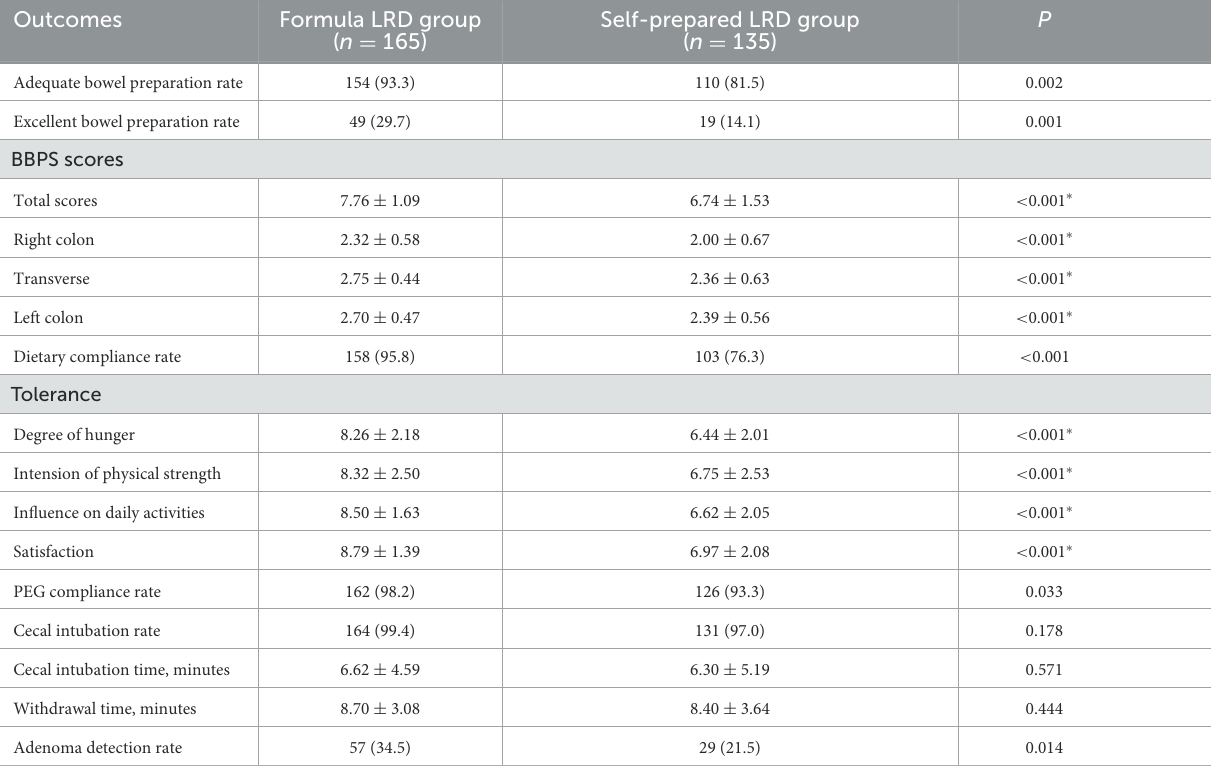
TABLE 5 Subgroup analysis of subjects aged 45 years or older.